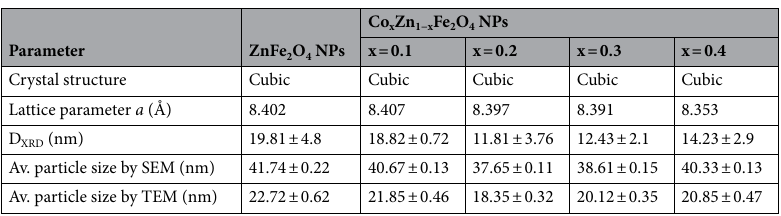
Table 1. Crystal structure, lattice parameter ( a ), Av. crystallite size ( D XRD ), Av. particle size determined by SEM and TEM of